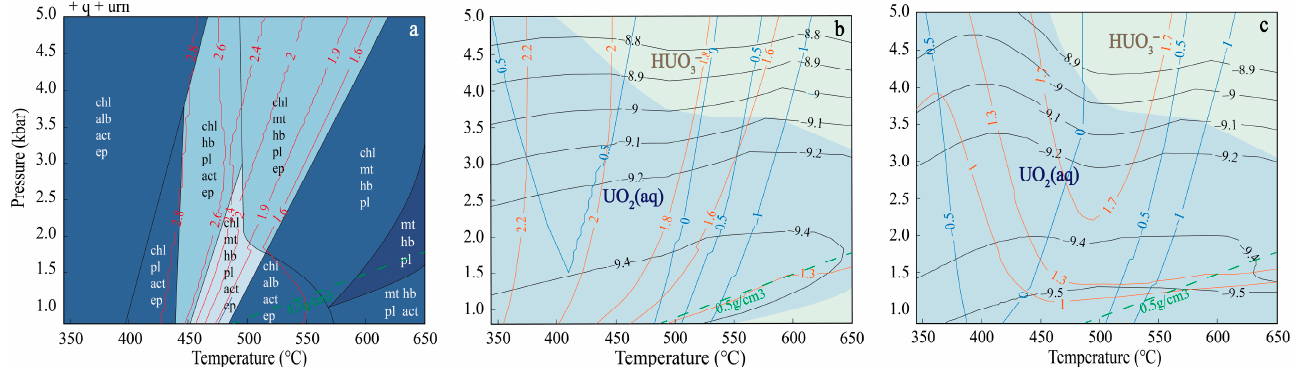
Figure 1. Results of thermodynamic simulation for fluids buffered by altered oceanic basalt. ( a ) P-T pseudosection showing mineral assemblage and content of lithological bound water; ( b , c ) solubilities of uranium in pure water and 5 wt.% NaCl-H 2 O solution, respectively. The solubility of uranium is shown as logarithm of molality (black line), and the predominance fields of different uranium species are presented by different colors. The orange lines in ( b , c ) denote different ∆ pH, which is the